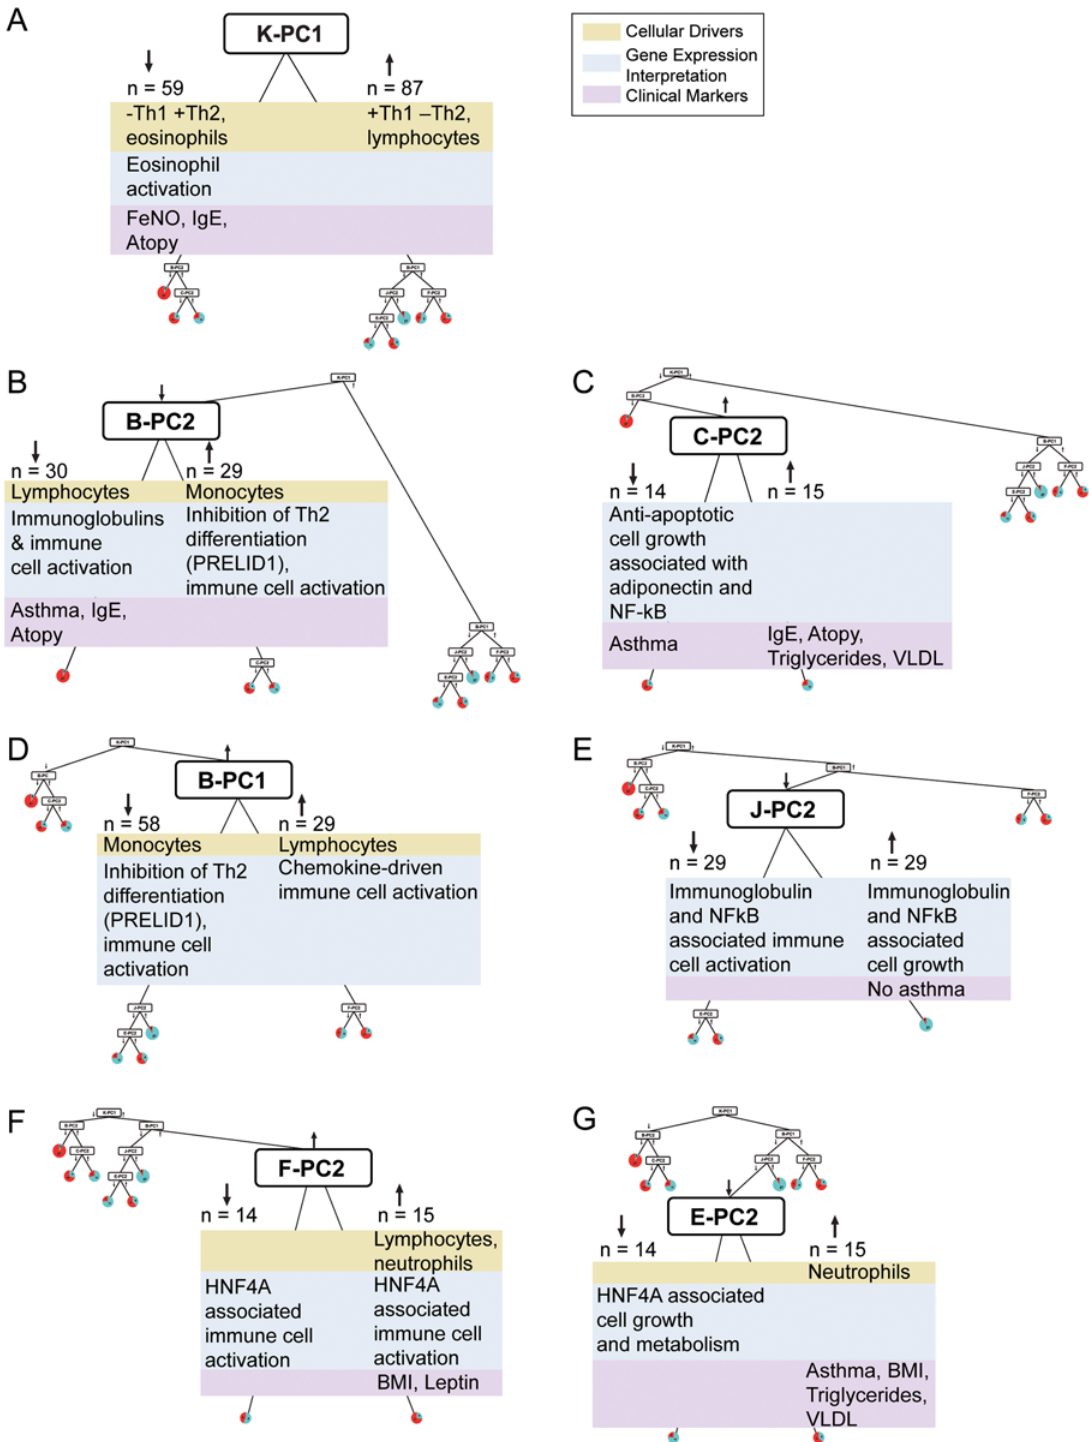
Fig 2. Mechanistic interpretation of the decision tree. Cellular drivers were determined by using linear regression as described in the methods and summarized in S1 Table. The results are summarized in green boxes. Gene expression changes were interpreted using Ingenuity Pathway Analysis (IPA). The top networks from IPA are listed in S2 Table along with their significance scores. All networks that were considered as part of the functional interpretation are included as S2 – S9 Figs. The final functional summaries from this analysis are shown in blue boxes. Clinical biomarkers (S3 and S4 Tables) correlated with the key genes from each metagene are shown in the purple boxes; atopy is based on allergen-specific IgE levels (S3 Table, Phadiatop) and IgE